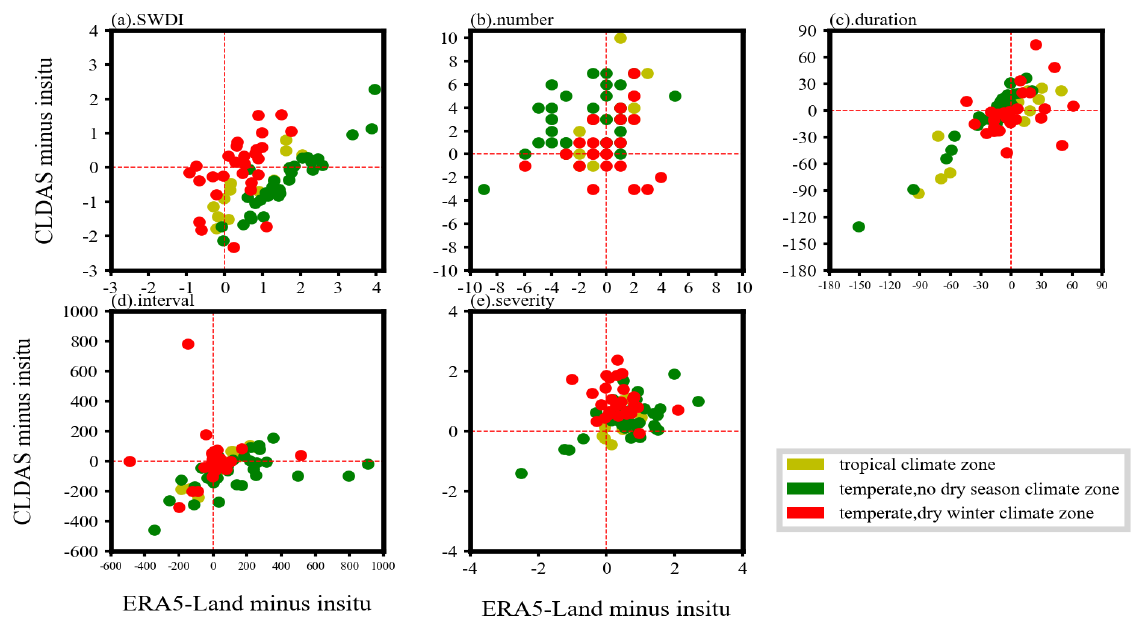
Figure 5. Comparison of ERA5-Land minus in situ and CLDAS minus in situ regarding the average SWDI ( a ), number ( b ), duration ( c ), interval ( d ), and severity ( e ) at each site (yellow points are sites in the tropical climate zone; green points are sites in the temperate, no dry season climate zone; and red points are sites in the temperate, dry winter climate zone) from 2013 to 2017.